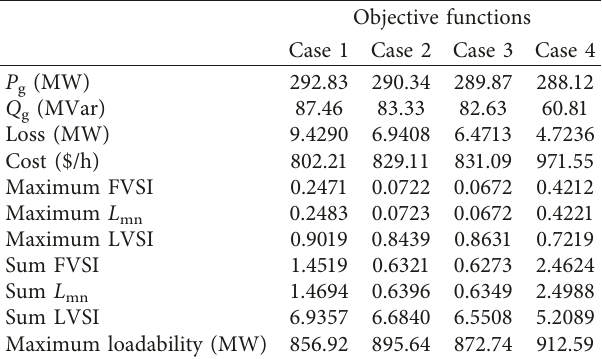
Table 1: System performance of the IEEE 30-bus test system. Objective